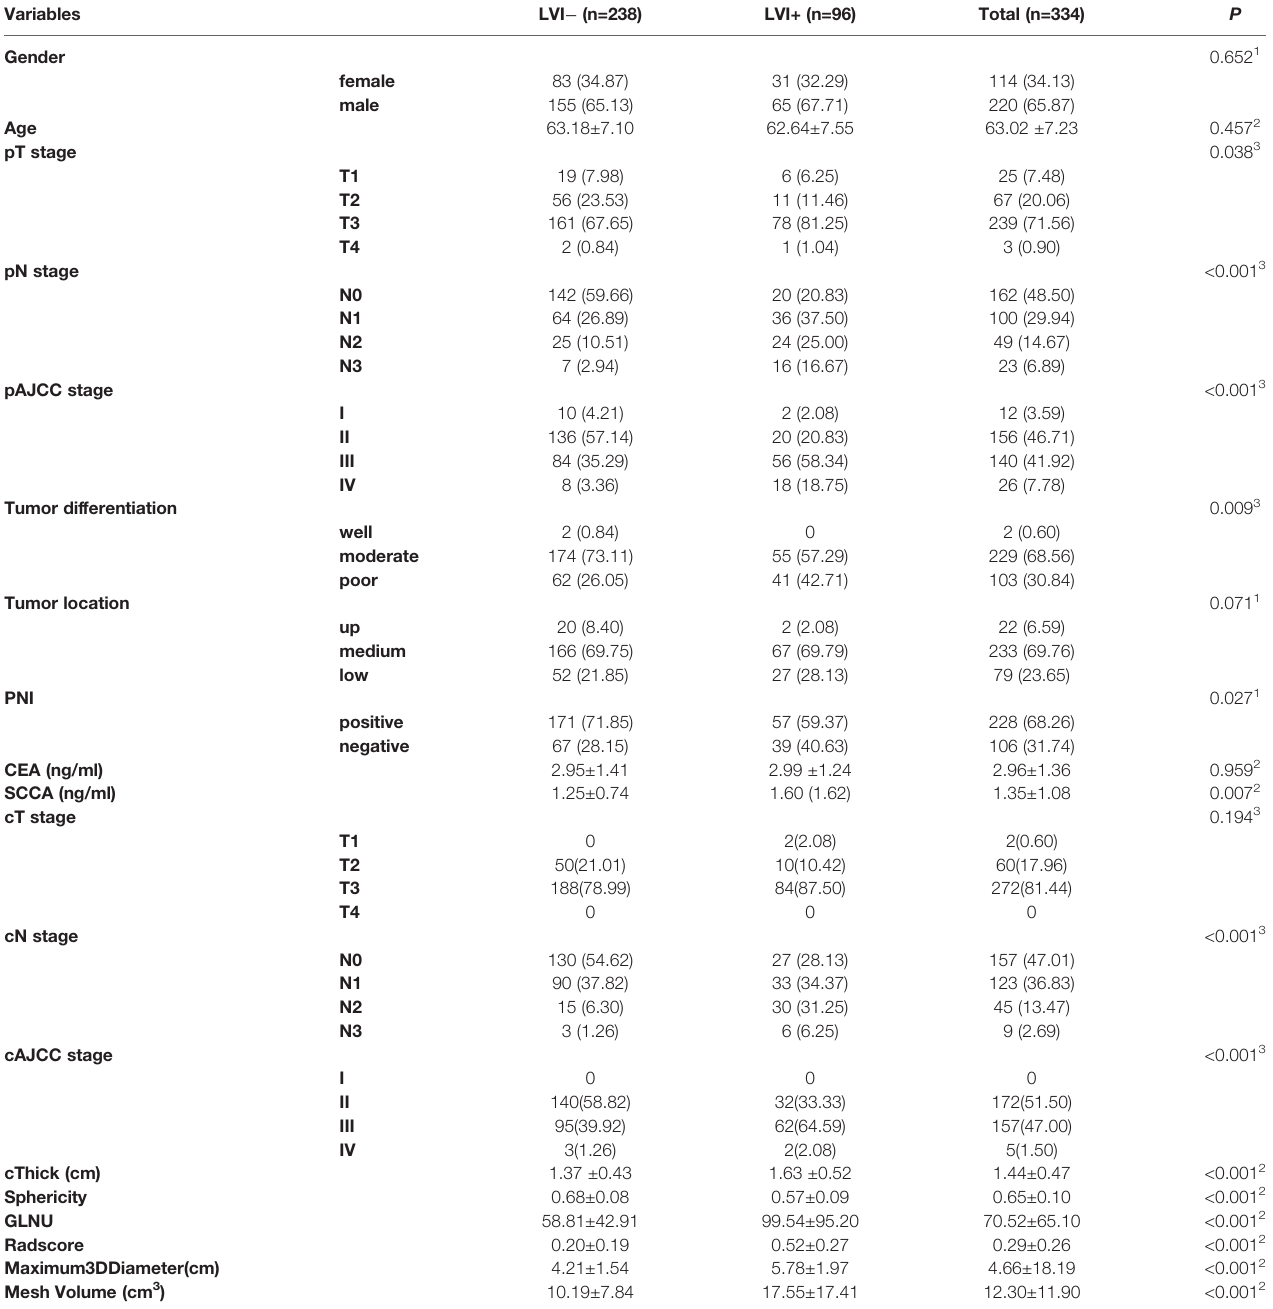
TABLE 1 | Clinical and pathological characteristics of the